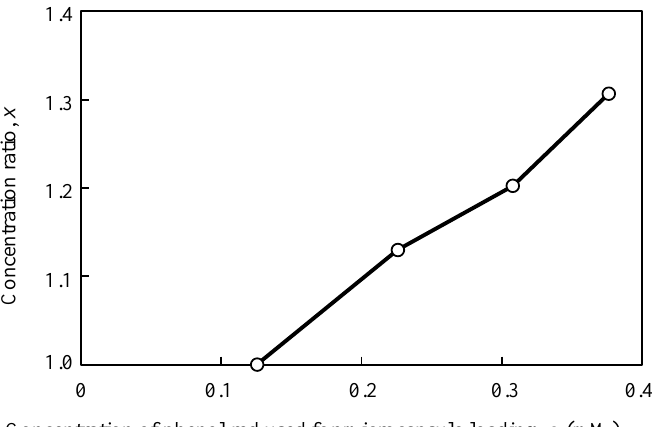
Figure 5. Time-course changes of optical densities for UV irradiation (wavelength 430 nm).  OD—change rate of the optical density. ( A ) Changes in optical density; ( B ) Schematic representation.